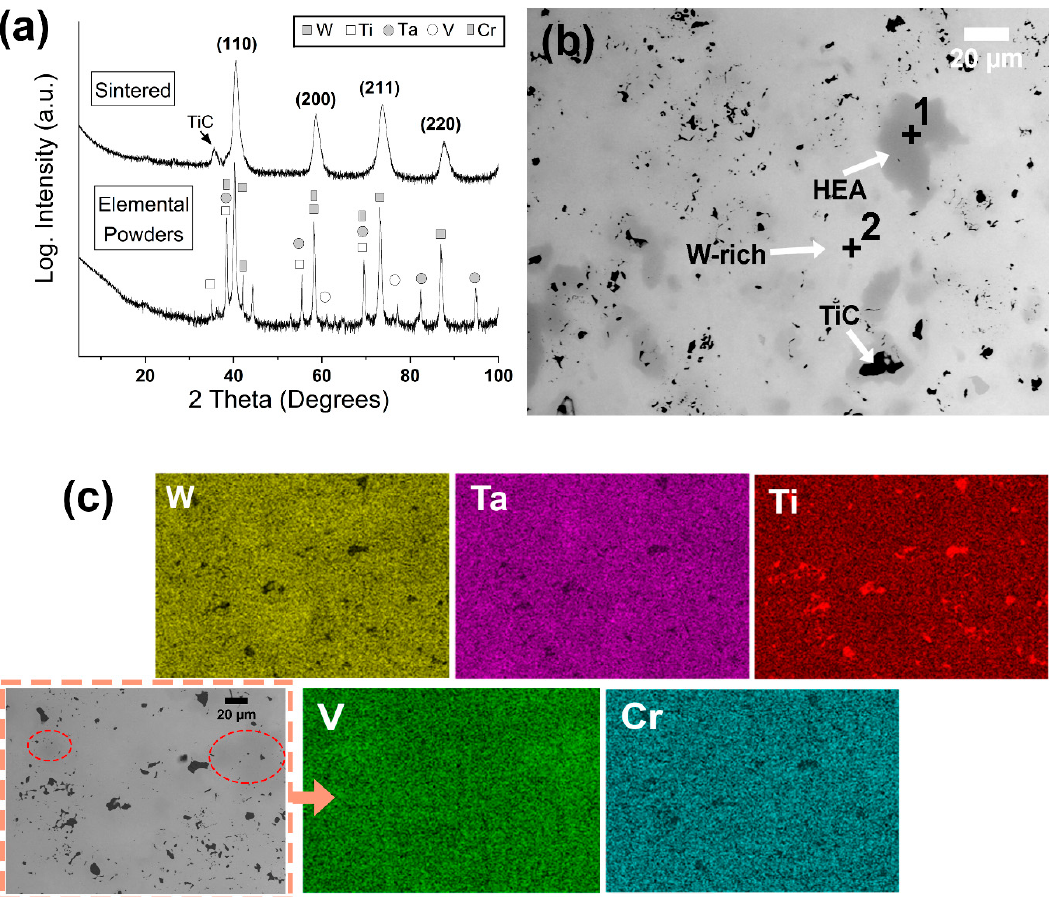
Figure 1. ( a ) X-ray diffraction (XRD) analysis plot, ( b ) backscattered scanning electron microscopy (SEM) micrograph, and ( c ) energy dispersive X-ray spectroscopy (EDS) elemental map of sintered W 0.5 (TaTiVCr) 0.5 alloy.